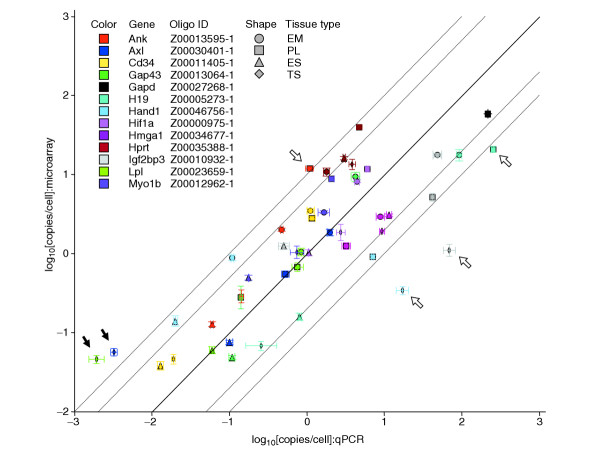
Validation of transcript abundance estimation for endogenous transcripts. qPCR primer sets were designed for selected genes so that amplicons were upstream of 60-mer oligonucleotide probes when possible, or less than 650 bp downstream, and copy number was estimated using serial dilutions of RNA, in vitro transcribed from mouse cDNAs, at known copy numbers as standards. Error bars represent one standard deviation across three replicate samples for each tissue. Dotted diagonal lines represent five- and tenfold differences between the two datasets. Each gene's official symbol, along with the unique identifier for the 60-mer oligonucleotide probe it was measured with, are listed in the key. Data was normalized to Gapd expression for both methods. EM = E12.5 embryo, PL = E12.5 placenta, ES = embryonic stem cells, TS = trophoblast stem cells.